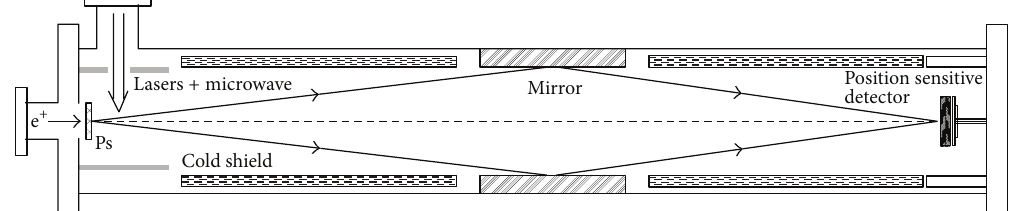
Figure 10: A schematic representation of a Mills-Leventhal type of Ps free fall experiment. A real experiment will undoubtedly be significantly different from this illustration, which is intended only to highlight some of the different steps involved. Of distinct practical concern will be the need to keep the apparatus at low temperatures to mitigate effects of black body radiation, as well as minimizing the Ps speed, which will determine the length of the flight path and hence the experiment.